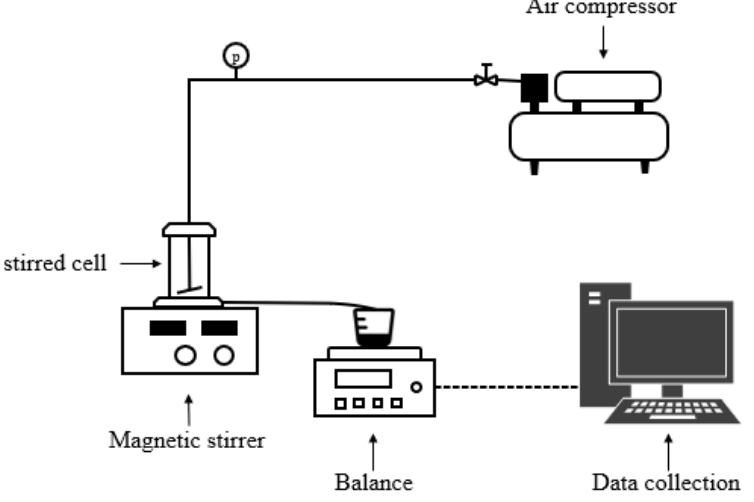
Figure 1. Layout of ultrafiltration setup .